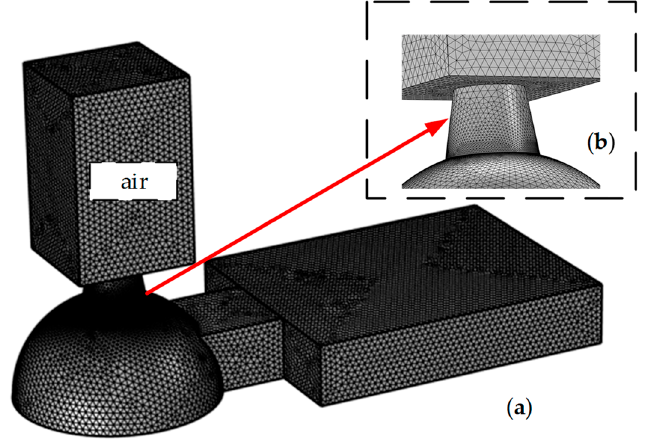
Figure 4. Mesh model of the hemispherical chamber. ( a ) The hemispherical chamber is divided into 952,384 units; ( b ) Enlarged view of nozzle and air domain